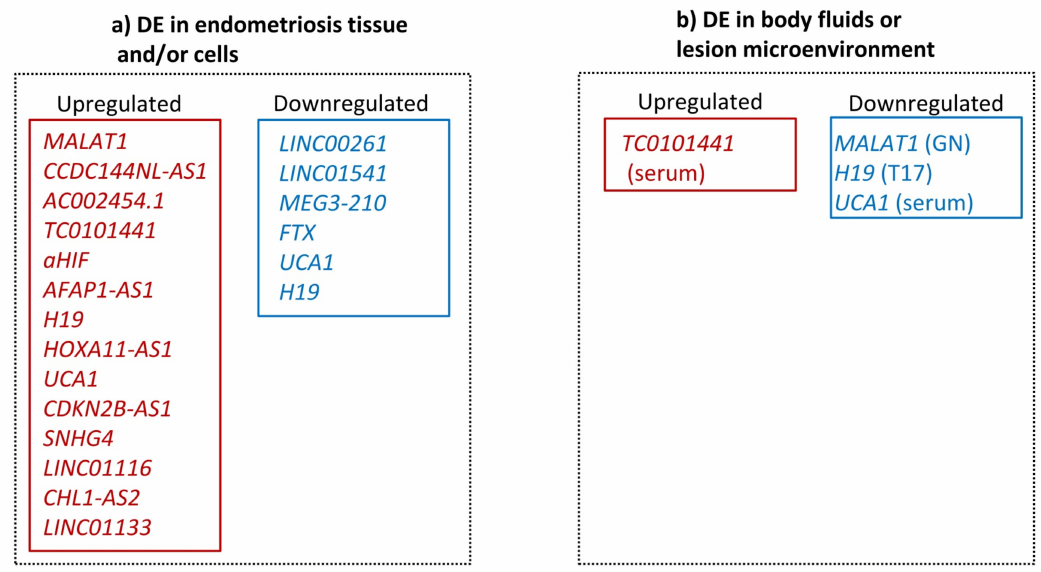
Figure 2. Differentially expressed (DE) lncRNAs in endometriosis based on validation studies: ( a ) Up- and downregulated lncRNAs in endometriosis tissues and/or cells ( b ) in body fluids or lesion